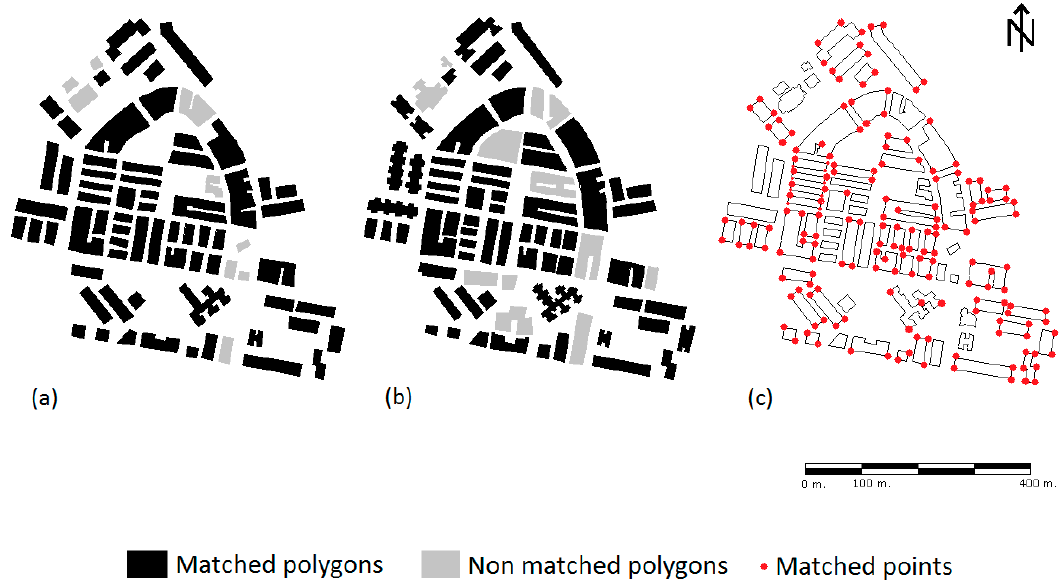
Figure 10. ( a ) Spatial distribution of matched and non-matched polygons (BCN25). ( b ) Spatial distribution of matched and non-matched polygons (MTA10). ( c ) Spatial distribution of matched point (Granada, Sheet 1009).